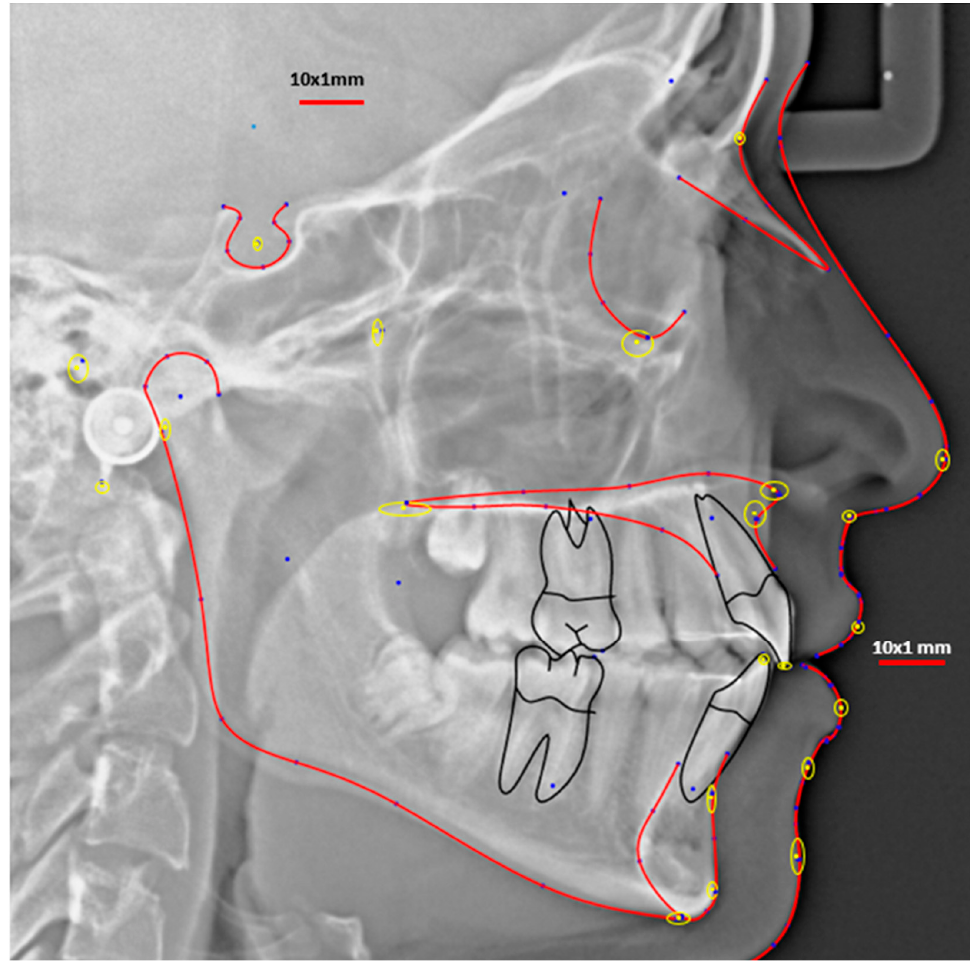
Figure 3. In situ scattergram of operator selected anatomic landmarks. The range of landmark se-